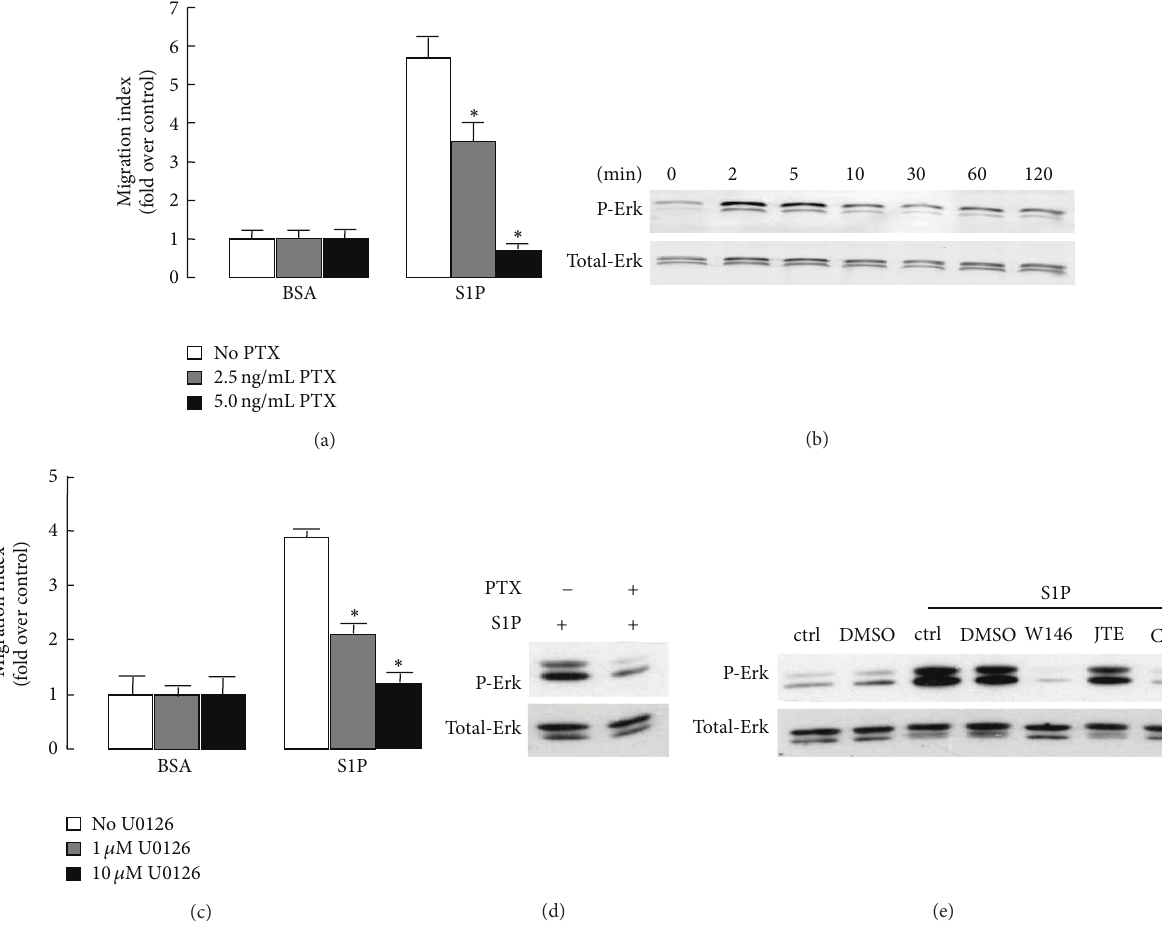
Figure 5: Involvement of the PTX-sensitive ERK1/2 pathway in S1P-induced migration of human BMSCs. (a), (c) Serum-starved BMSCs were pretreated with the indicated concentration of PTX (a) or U0126 (c) and then were allowed to migrate for 4h in the presence of 1nM S1P. (b) The effect of S1P on the activation of ERK1/2 MAPK. Cells were stimulated with S1P (1 𝜇 M) for the indicated time and cell lysates were analyzed by western blot. (d)-(e): The effect of S1PRs antagonists (S1PR1 antagonist W146, S1PR2 antagonist JTE-013, and S1PR3 antagonist CAY1444) and PTX on S1P-induced activation of ERK1/2. Cells were pretreated with S1PRs antagonists (d) or pretreated with 5ng/mL PTX (e). The pretreated cells were stimulated with 1 𝜇 M S1P for 2min, and cell lysates were analyzed by western blot. Data are presented as the mean ± SD. ∗ 𝑃 < 0.05 , compared with